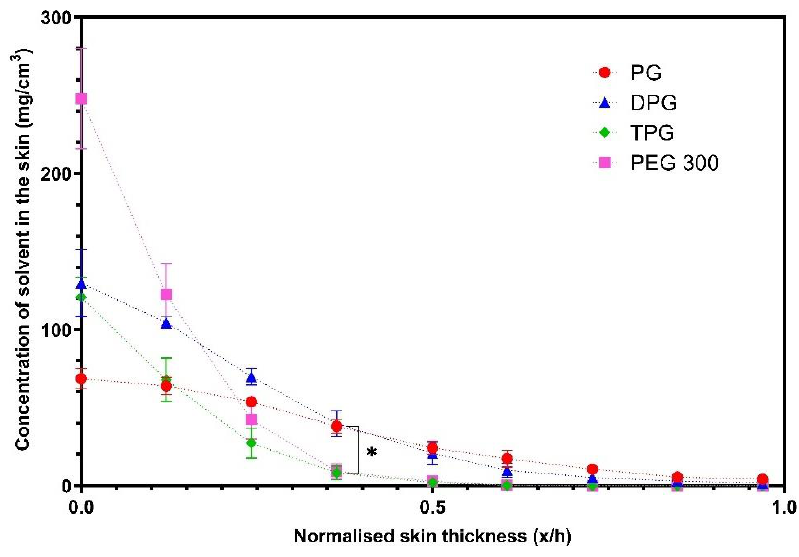
Figure 8. Concentration profiles of vehicles (mg/cm 3 ) in the SC after application of various vehicles (mean ± SEM, 4 ≤ n ≤ 5, * p < 0.05). (mean ± SEM, 4 ≤ n ≤ 5, * p <